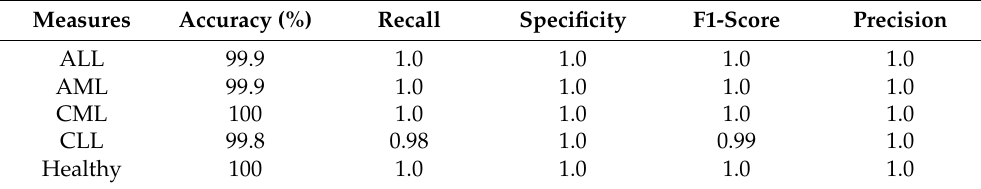
Table 4. The effectiveness of the suggested model for identifying leukemia subtypes.